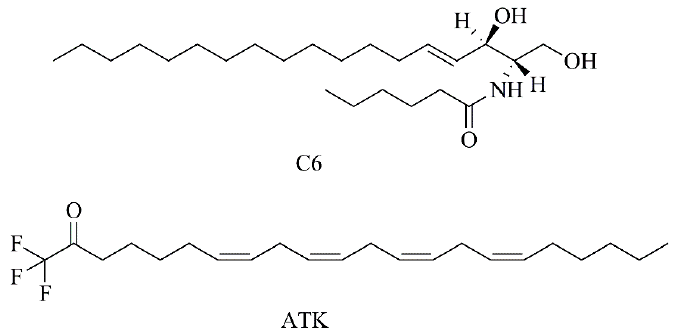
Figure 12. Chemical structures of Ceramide 6 (C6) and ATK.